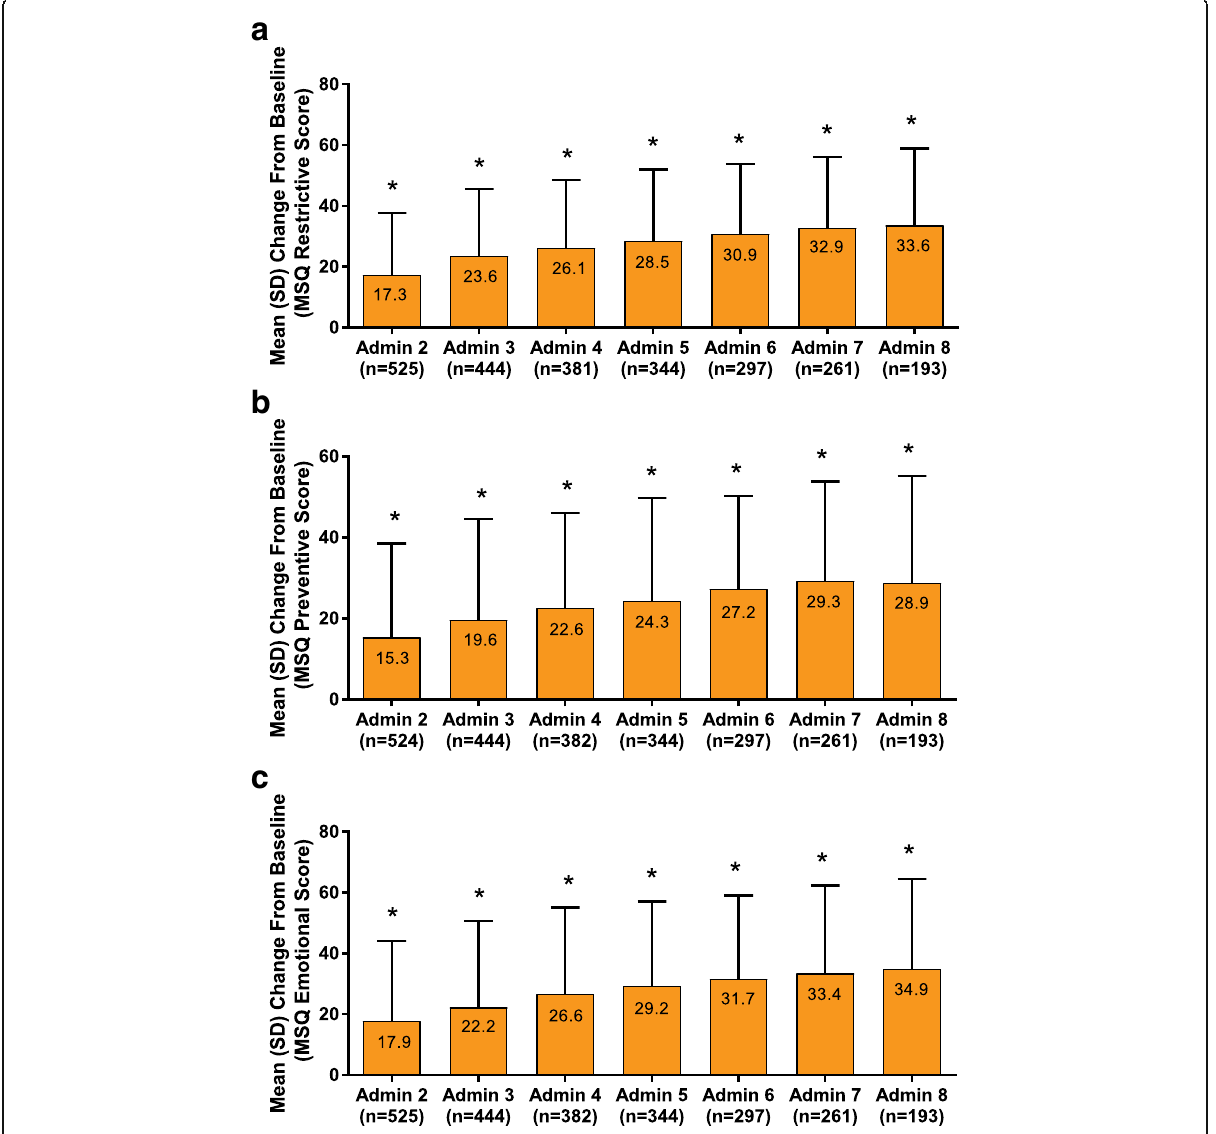
Fig. 2 Mean (SD) change from baseline in all MSQ dimensions. a ) Mean role-function restrictive score at baseline was 36.2 (17.8); b ) mean role-function preventive score at baseline was 50.2 (22.8); c) mean role-function emotional score at baseline was 42.4 (25.6; P < 0.001). All dimensions evaluated at administration visit 2 through administration visit 8. † MSQ = Migraine-Specific Quality-of-Life Questionnaire. * P < 0.001 Wilcoxon signed rank test for change versus baseline (level of significance, 5%). † The numbers of patients in administration (Admin) visits 9 – 13 in all dimensions were as follows: Admin 9, n = 117; Admin 10, n = 50; Admin 11, n = 23; Admin 12, n = 13; Admin 13, n = 6. Mean changes from baseline for the restrictive and preventive scores Admin visits 9 – 13 were each significant (Admin 9 – 12, P < 0.001; Admin 13, P = 0.031).